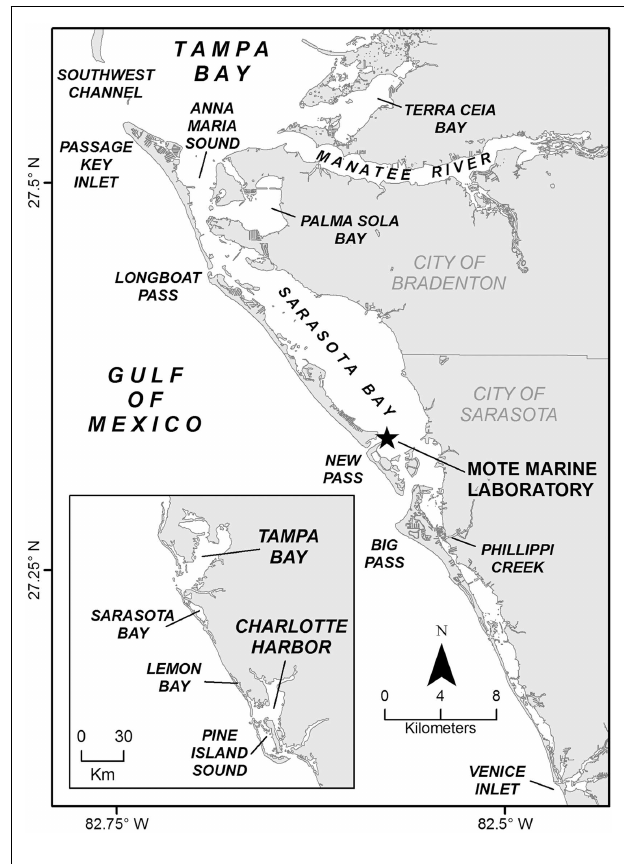
FIGURE 1 | Long-term study area of the Sarasota Dolphin Research Program along the central west coast of Florida . Field base at Mote Marine Laboratory